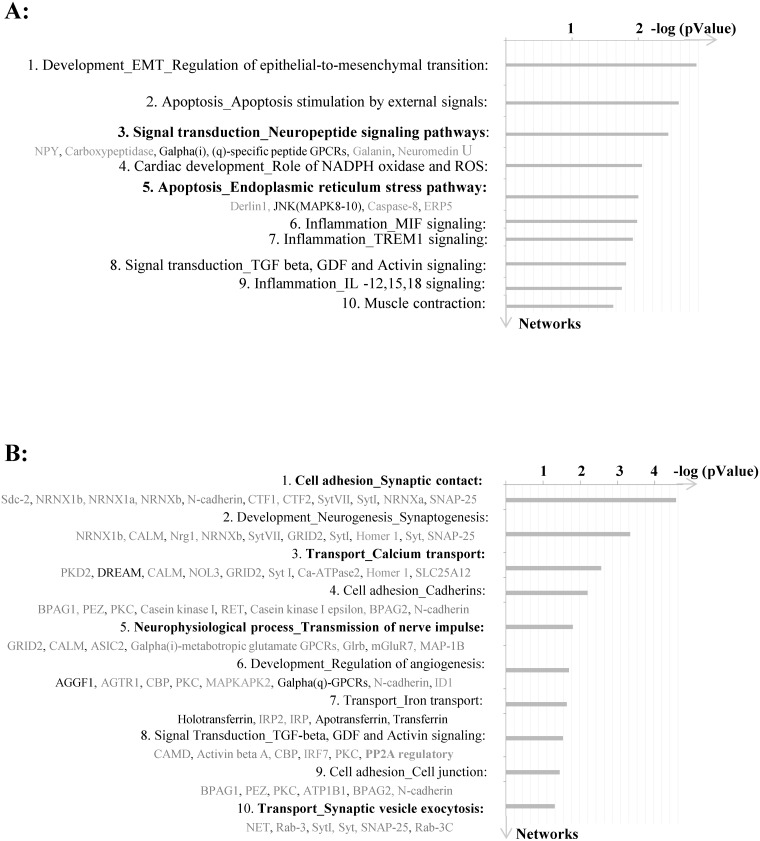
Enrichment analysis of DEGs in 2RH and 2RS experimental groups.A) Shown is the distribution by process networks at 0 time point (2RH0 vs. 2RS0) and B) at 60 min time point (2RH60 vs. 2RS60). Sorting is done for unique genes and both signals (induced genes—shown in red and repressed genes—in blue) included. Top 10 process networks are listed based on their—log (p-value). For list of abbreviations see supplemental file S1 Text.